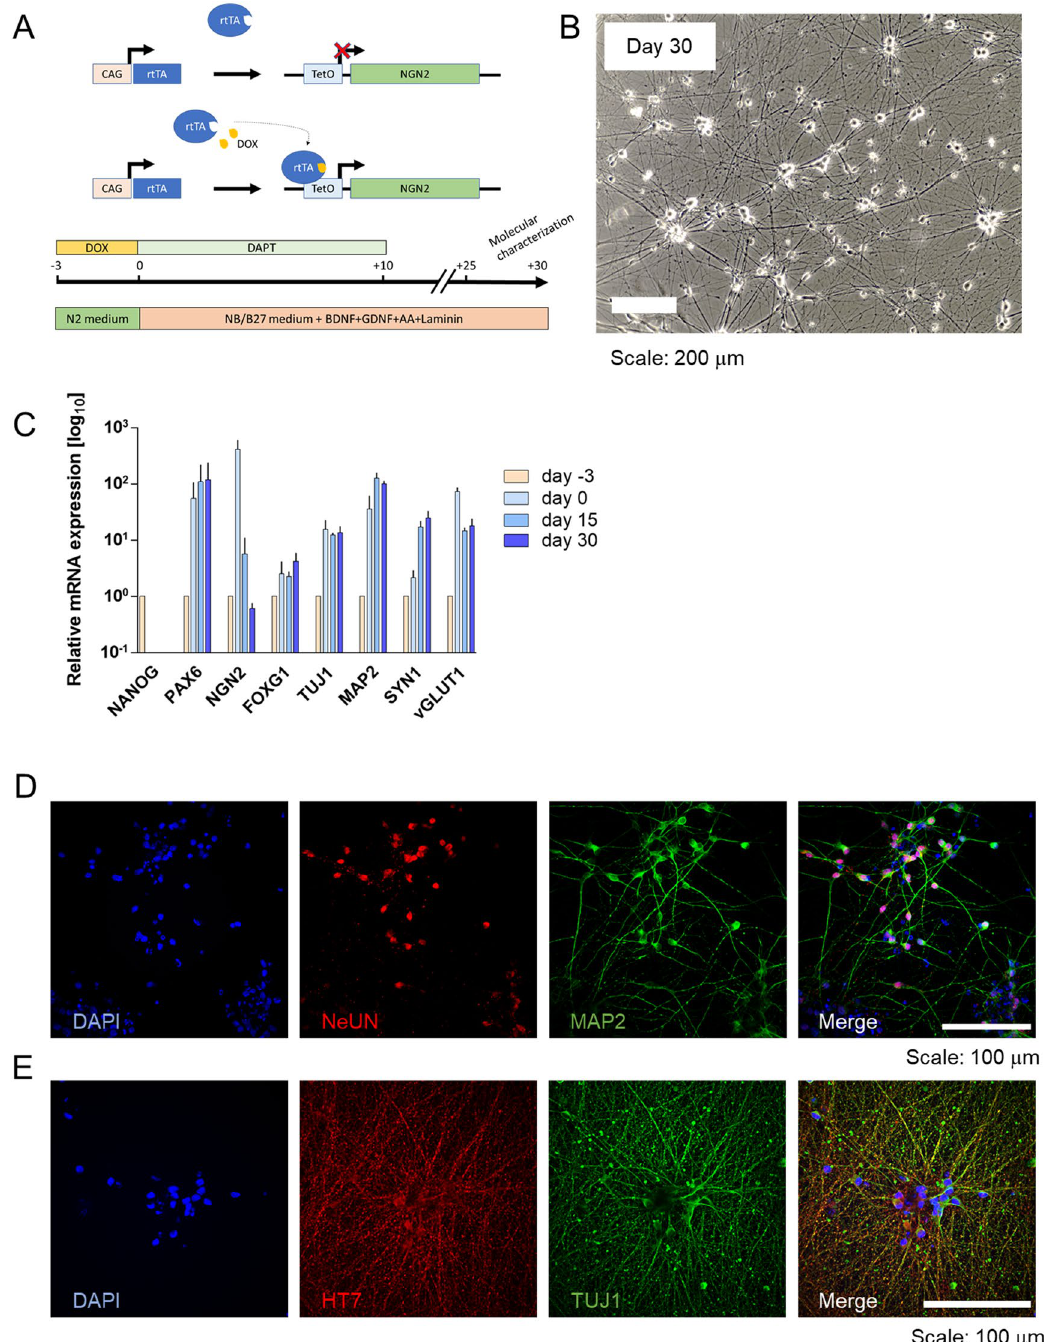
Figure 4. Molecular and cellular characterization of human iPSC derived NGN2 cortical neurons. ( A ) Schematic representation of the doxycycline-based strategy used for inducing the tuned expression of human NGN2 transcript. ( B ) Representative transmitted image of human iPSC-derived cortical neurons at day 30 in vitro. Scale bar 200 µm. ( C ) Real-time qRT-PCR analysis of specific molecular markers expression in human iPSC-derived cortical neurons at different time points of differentiation (n = 3 differentiation batches). ( D ) Representative images of immunostaining for NeUN (red), and MAP2 (green) expression in human iPSC- derived cortical neurons at day 30. Nuclei are stained in blue. Scale bar: 100 µm. (E) Representative images of immunostaining for total tau protein (HT7, red), and TUJ1 (green) expression in human iPSC-derived cortical neu-rons at day 30. Nuclei are stained in blue. Scale bar: 100 µm. (ImageJ software bundled with Java 1.8.0_172 software; URL: https:// imagej. nih. gov/